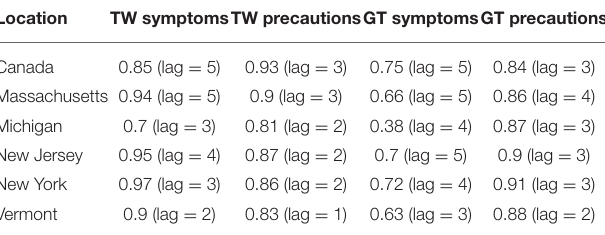
TABLE 4 | Correlation coefficients (r) of weekly online activities and COVID-19 cases.